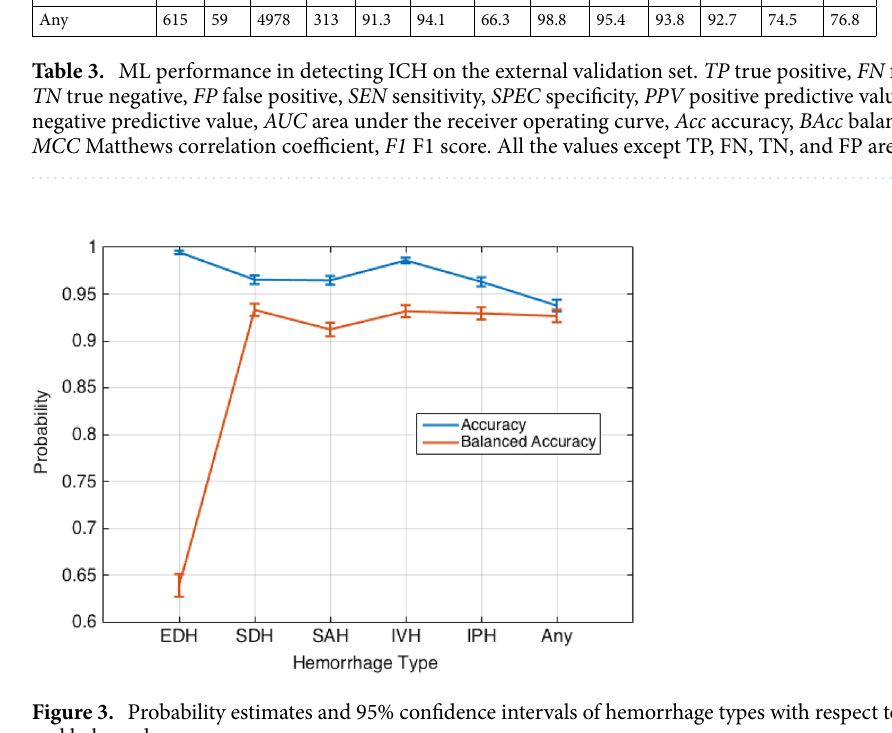
positive predictive value of 66.3% and negative predictive value of 98.8% for ICH detection (Table 3). The 95% CI with respect to the balanced accuracy score for each hemorrhage class is as follows: EDH (± 1.22%), SDH (± 0.63%), SAH (± 0.72%), IVH (± 0.64%), IPH (± 0.65%), and ICH (± 0.66%) (Fig. 3). The 95% CIs of EDH show a 35.58% difference between the CI of the accuracy and balanced accuracy scores. This indicates high generaliza- tion performance of the ML model for all types of ICH except EDH. Receiver operating characteristic (ROC) curves were created using the external dataset by generated probabilities per ICH type (Fig. 4a) and generated decisions after applying thresholds (Fig. 4b). A higher positive predictive value, accuracy, Matthews correlation coefficient, and F1 score were demonstrated with matched prevalence between the test and external validation datasets (Table 4). Figure 5 shows the distribution of predicted hemorrhage probability by the ML model for the external valida- tion dataset at the patient level. This figure shows that the probability distribution of prediction for both negative and positive EDH cases is very similar. Figure 6 shows the cumulative positive cases between the ML model